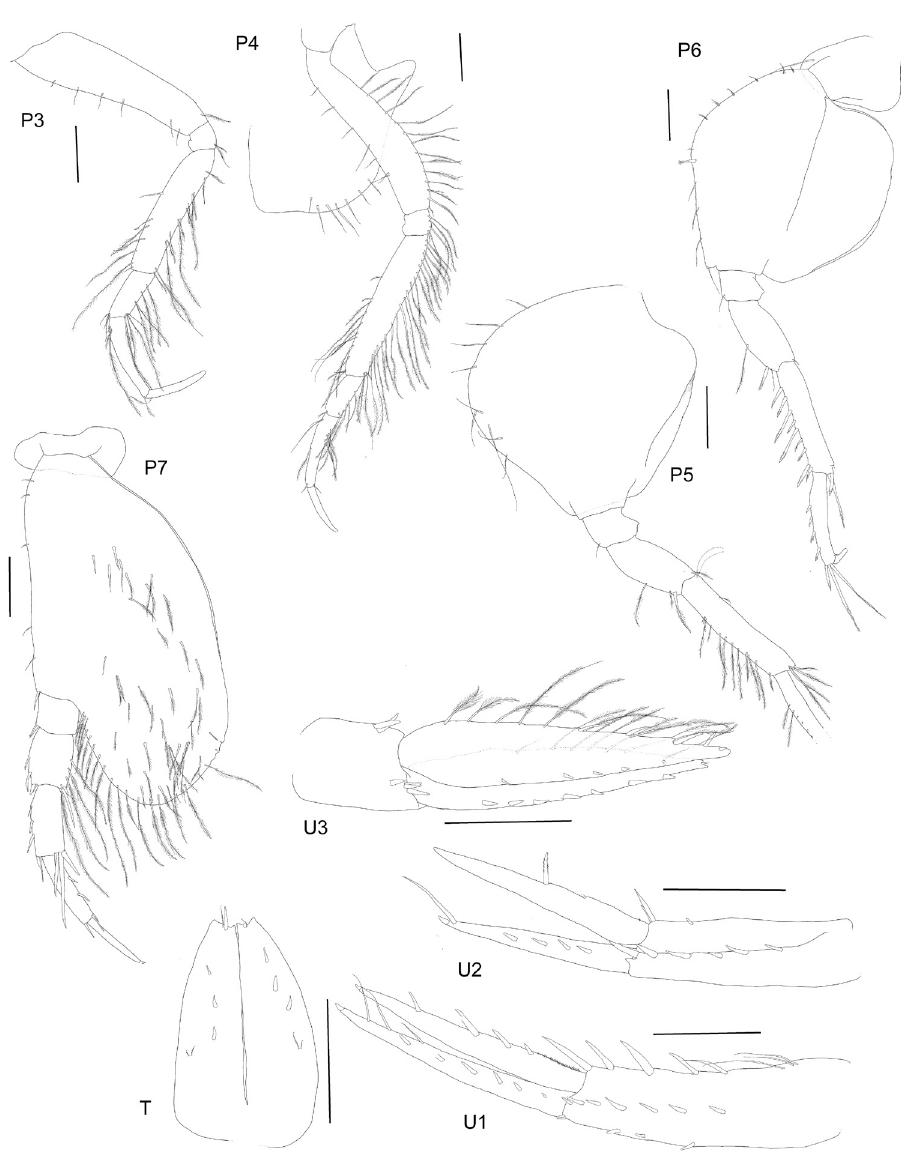
Figure 4. Byblisoides bellansantiniae sp. n. Holotype, female, 14 mm, ZMH K-47035, Irminger Basin, Iceland, 2537.3–2538.1 m. Scales represent 0.5